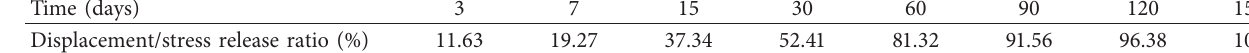
Table 4: The calculated displacement release rate with time.